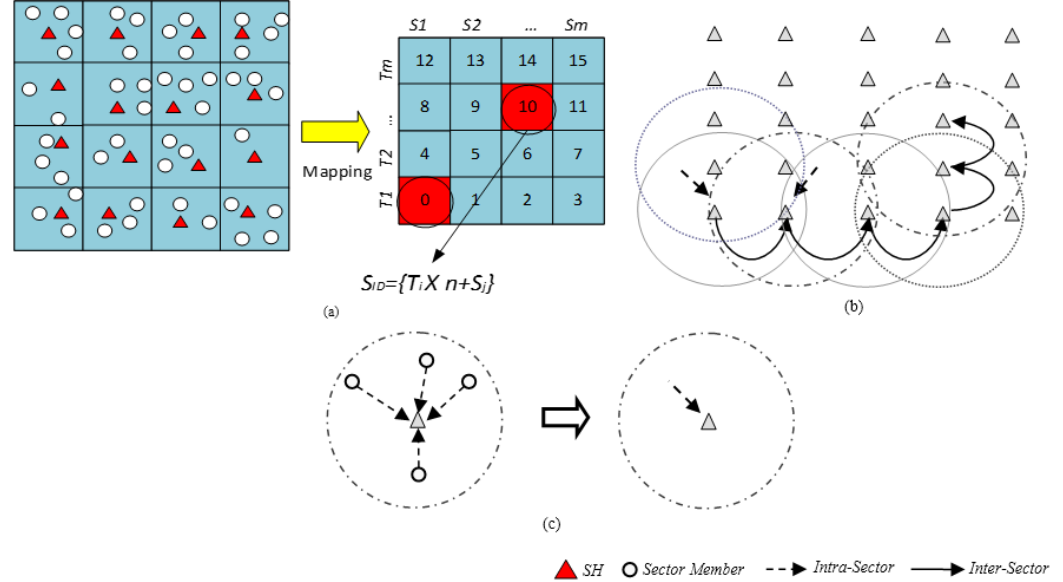
Figure 3. ( a ) DBDCS Mapping; ( b ) inter-sector communication; and ( c ) intra-sector member node to head node communication